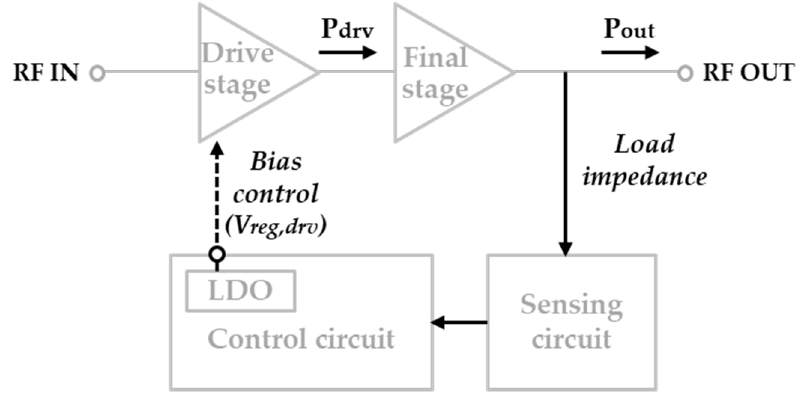
Figure 6. Block diagram of proposed closed-loop protection circuit.